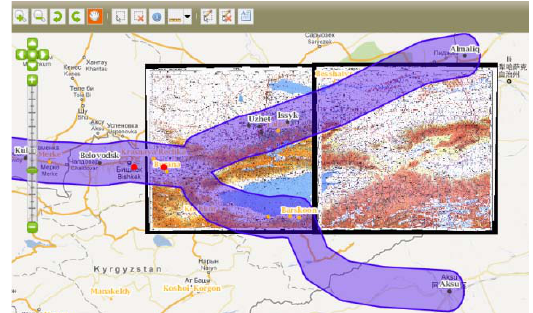
Figure 5: Example of georeferenced scanned topographic maps © Silk Roads CHRIS.